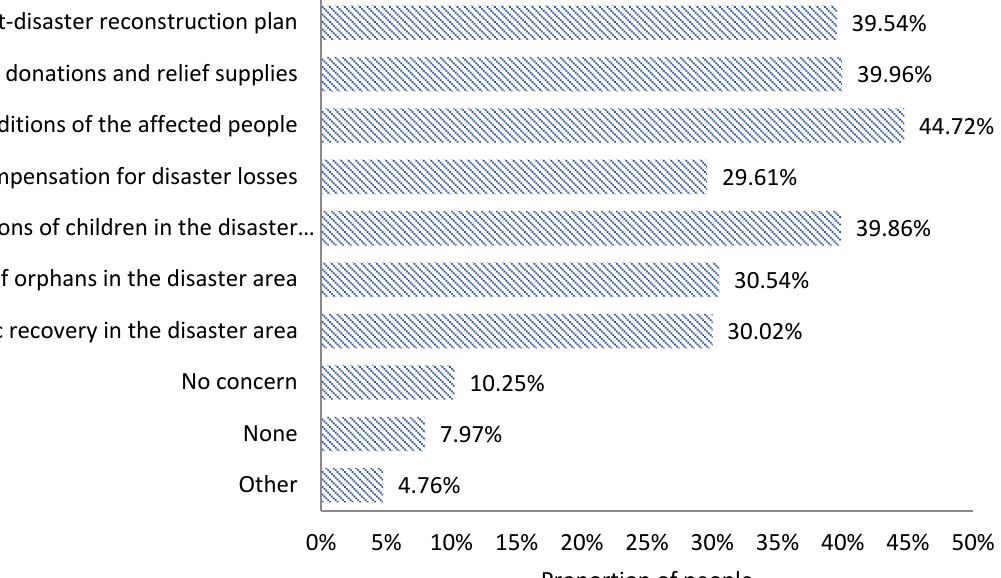
Figure 8. Information expected to be acquired by the public in the resolution stage of an earthquake disaster.